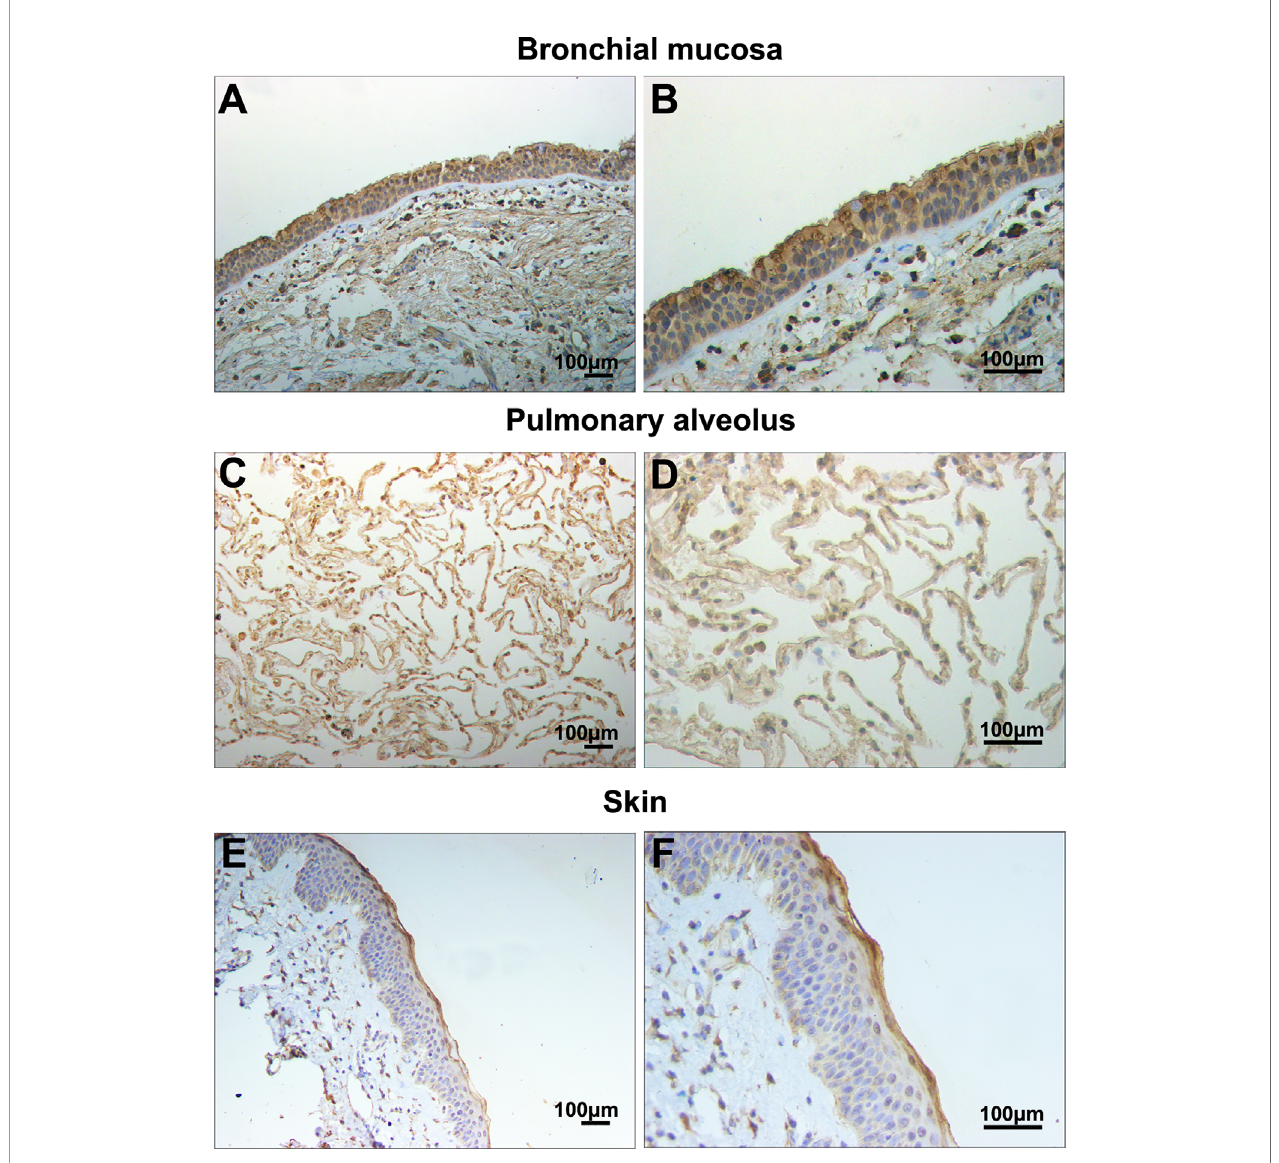
FIGURE 2 | Filaggrin was expressed in normal human bronchial epithelial cells and alveolar epithelial cells. Identi fi cation of fi laggrin expression in normal human bronchial mucosa (representative example of n=6), pulmonary alveolus (representative example of n=5) and skin tissues (representative example of n=3) by immunohistochemistry (IHC). Magni fi cation of (A, C, E) :100×; (B , D , F) :200×. Bar=100 m